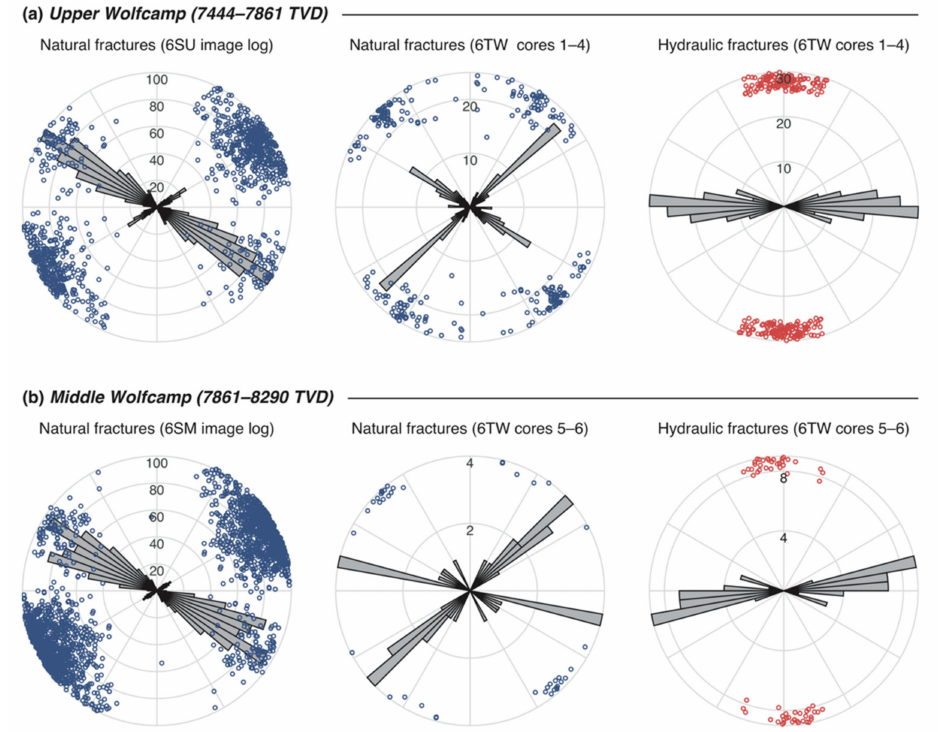
Figure 7. Fracture data from image logs and recovered core. ( a ) Upper Wolfcamp fractures. Natural fractures identified in well 6SU. Number of fractures, N = 503. Natural fractures ( N = 148) and hydraulic fractures ( N = 134) identified in well 6TW cores 1–4. ( b ) Middle Wolfcamp fractures. Natural fractures identified in well 6SM ( N = 1012). Natural fractures ( N = 23) and hydraulic fractures ( N = 33) identified in well 6TW cores